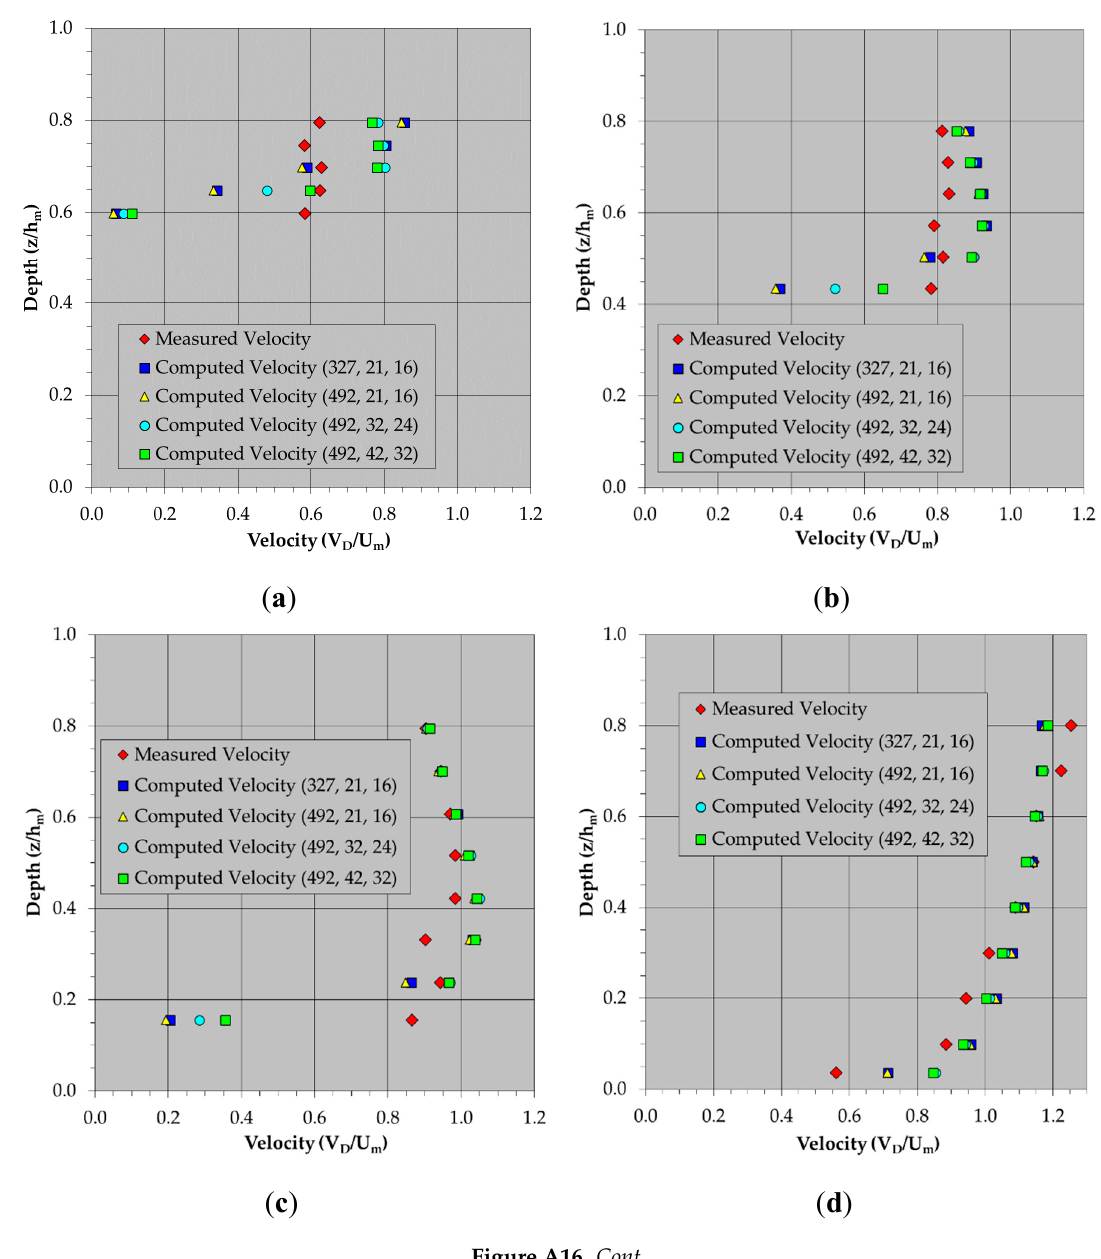
Figure A16. Cont